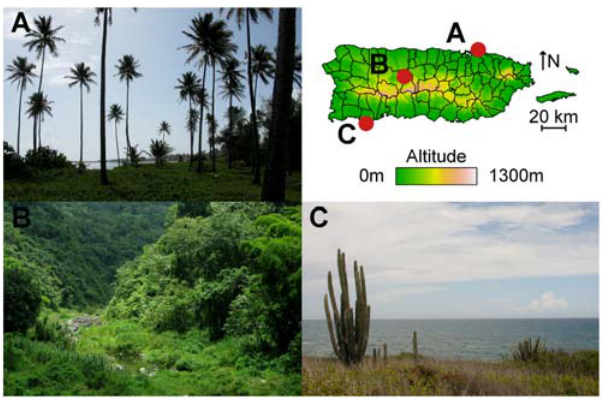
Figure 2. Elevation and climate variation in Puerto Rico. The map shows the location of each photograph. Natural areas of northern Puerto Rico are moist subtropical forest. Higher elevations are subtropical or montane wet or rain forests. The southwestern coast is subtropical dry forest. Figure S1 shows monthly temperature and precipitation in proximal